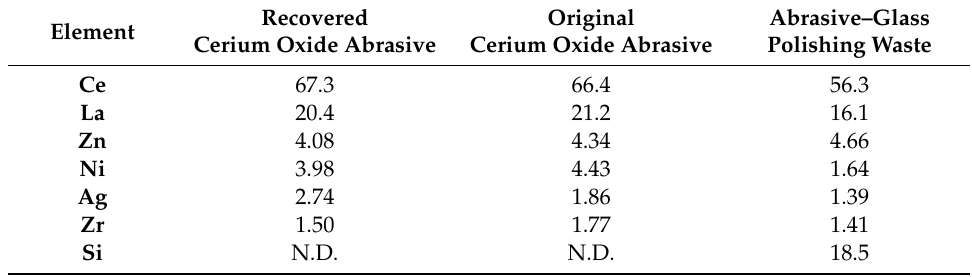
Table 1. Elemental composition of the recovered cerium oxide abrasive, the original cerium oxide abrasive, and the abrasive–glass polishing waste (experimental conditions of the recovered cerium oxide abrasive: abrasive–glass polishing waste: approximately 1 g; roasting temperature: 450 ◦ C; mass ratio of polishing waste to NaOH: 1:1; roasting time: 30 min; water leaching pH: 3, leaching temperature: 25 ◦ C, liquid–solid ratio of 25 mL / g). Recovered Original Abrasive–Glass Element Cerium Oxide Abrasive Cerium Oxide Abrasive Polishing Waste